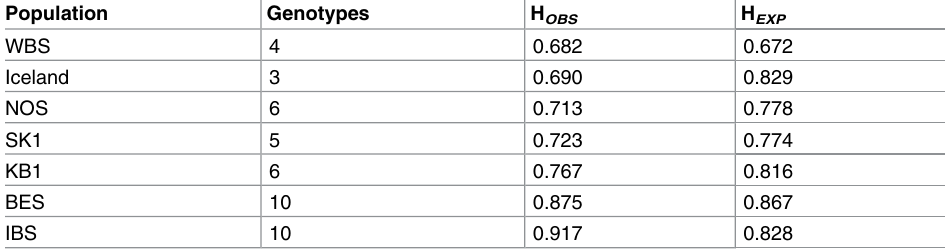
Table 2. Averageobserved and expected heterozygosities per population for